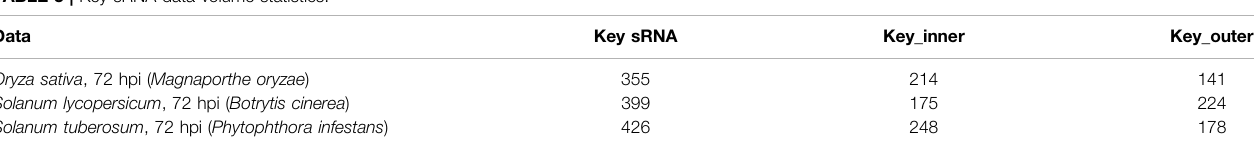
TABLE 3 | Key sRNA data volume statistics.